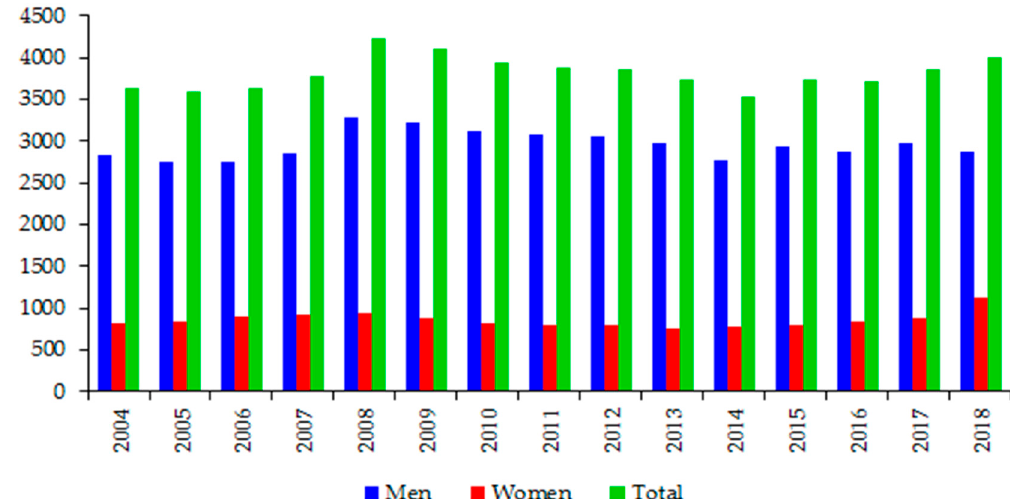
Figure 4. Employment generated by the mineral water packaging industries in Spain for the years 2004–2018. Source: Geological and Mining Institute of Spain, Statistics of bottled mineral water in Spain. Spain comes fourth in the European Union in terms of both the number of bottling plants and by